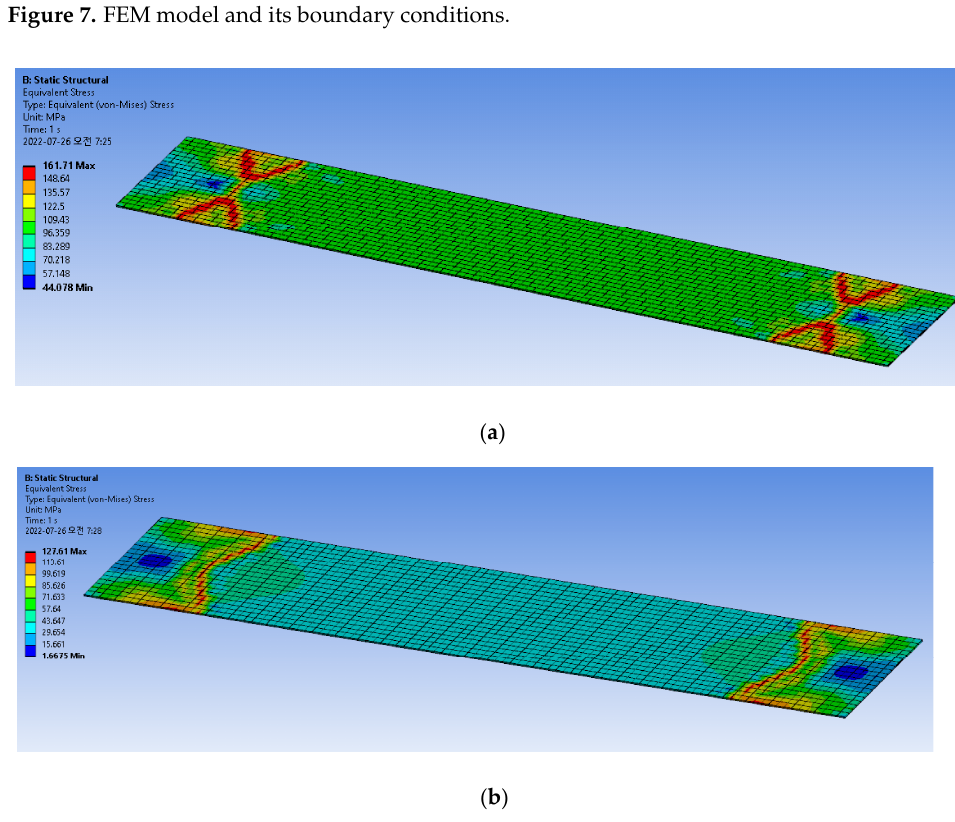
Figure 8. FPCB and PSPI stress distributions during tensile tests. ( a ) FPCB stress distribution when t = 10 µm. ( b ) PSPI stress distribution when t = 10 µm. t = 10 µ m. ( b ) PSPI stress distribution when t = 10 µ